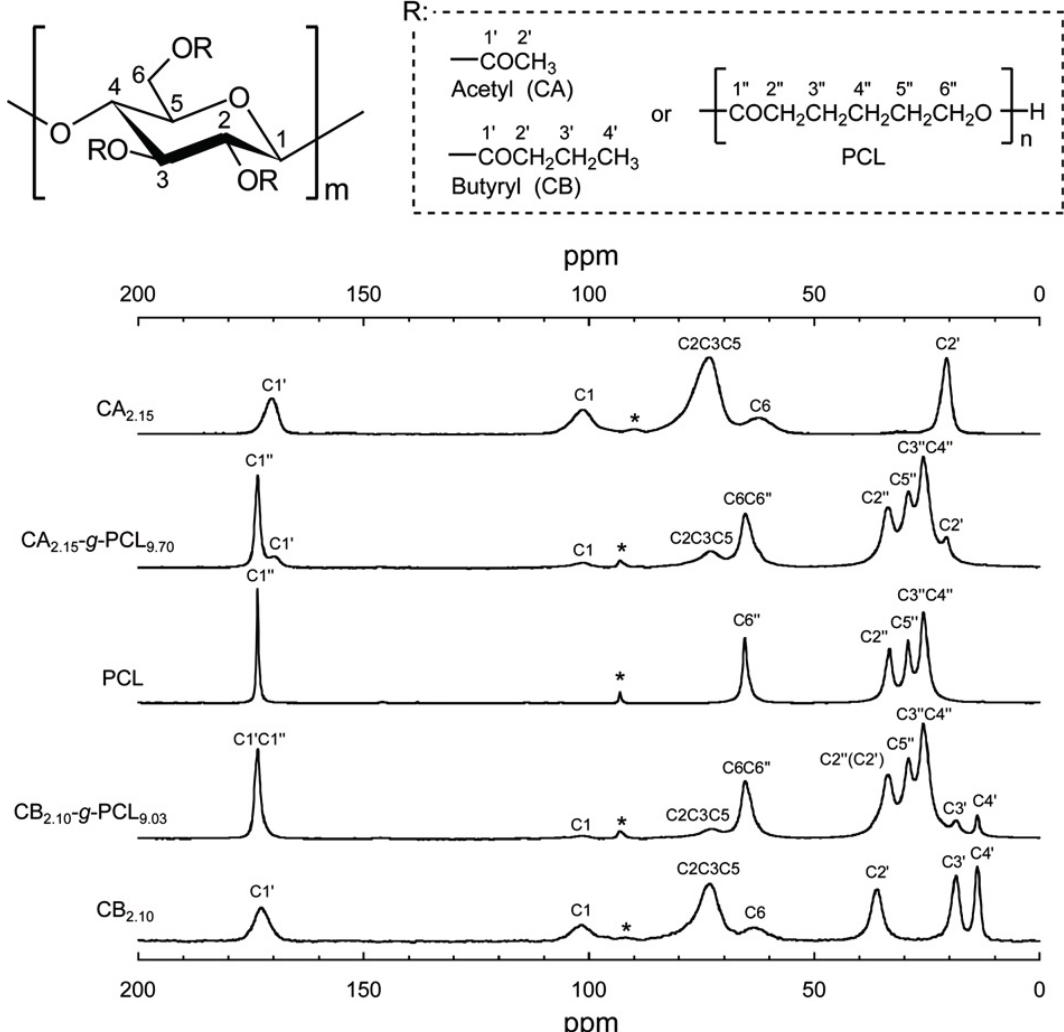
Figure 24. Solid-state 13 C CP/MAS NMR spectra of CA 2.15 (DS = 2.15), CA 2.15 - g -PCL 9.70 , plain PCL, CB 2.10 - g -PCL 9.03 , and CB 2.10 , and their peak assignments. Asterisks denote a spinning sideband overlapping with the C4 pyranose carbon resonance signal. The C2" peak for CB 2.10 - g -PCL 9.03 overlaps with the low intensity peak of the butyryl substituent C2'. Reproduced with permission from ref. [60]. Copyright 2011 Elsevier